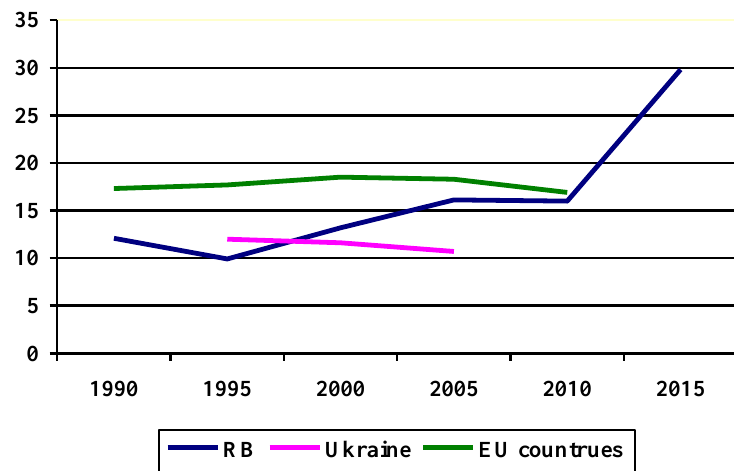
Fig. 1. Dynamics of the change of indicators, which is investigated in the reference countries (indicative points of the comparative